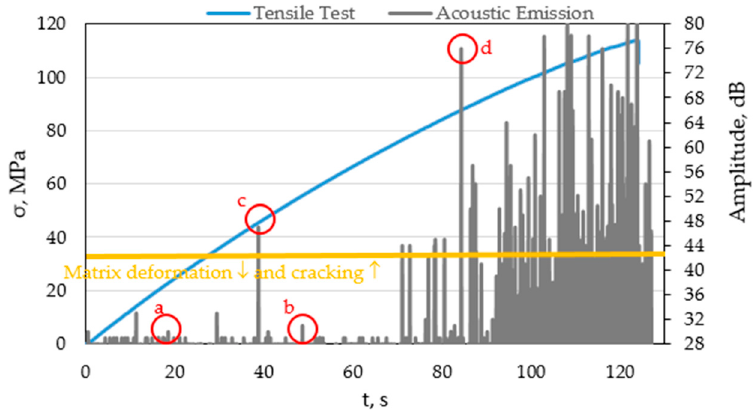
Figure 5. Amplitude diagrams plotted on the tensile diagrams as a function of time for a selected sample based on a glass fibre-reinforced polyester resin with the marked area of deformation and cracking of the matrix and marked points for further analysis: (a,b) matrix deformation, (c) matrix cracking, (d) cracking of fibers.